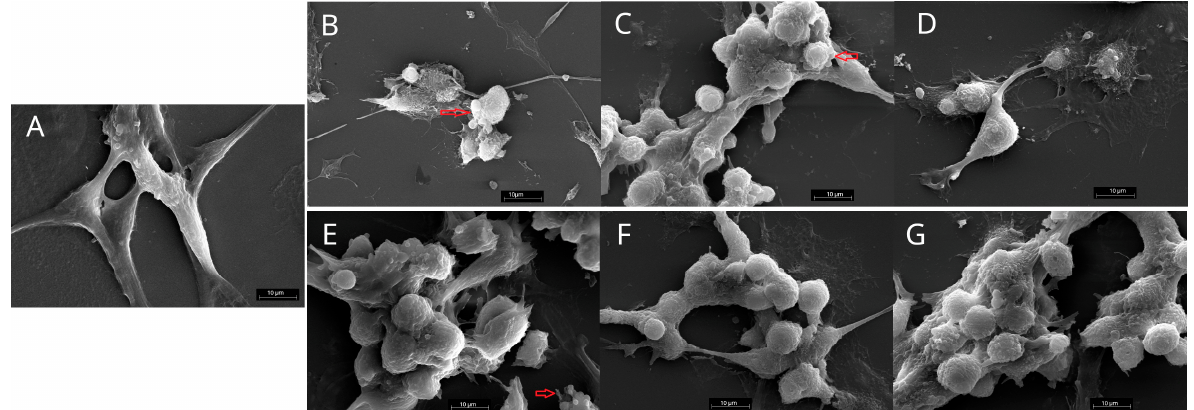
Figure 5. Micrograph obtained by scanning electron microscopy of 9 L/lacZ cells irradiated in an LED device at 660 nm, 5 J/cm 2 , and 25 mW/cm 2 , representing light control ( A ). Cells 9 L/lacZ submitted to PDT in the fluence of 5 J/cm 2 and 25 mW/cm 2 with 1.55 µg mL − 1 FTC ( B ); 12.5 µg mL − 1 FTC ( C ); 50 µg mL − 1 FTC ( D ); 1.55 µg mL − 1 PDZ ( E ); 12.5 µg mL − 1 PDZ ( F ); and 50 µg mL − 1 PDZ ( G ). Red arrow: signs of apoptosis; Magnification: 1.50 k×. Bar = 10 µM.